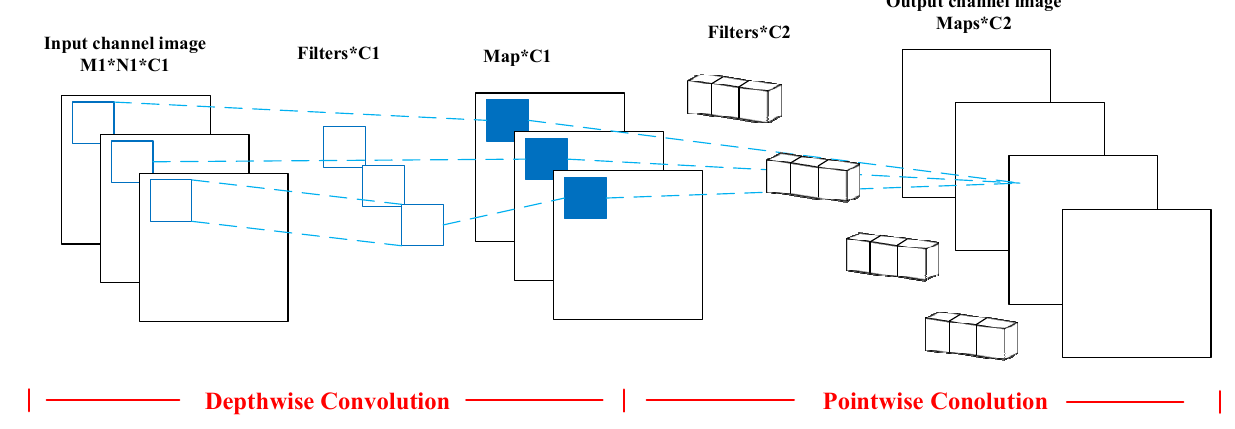
Figure 6. DwConv module